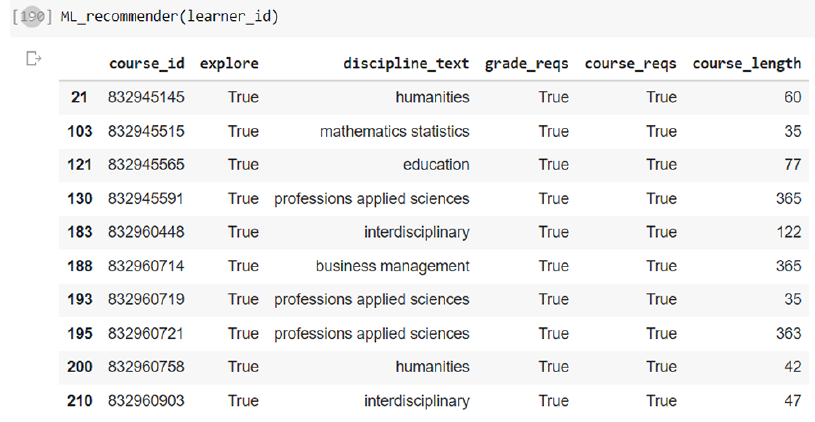
Fig. 9. Machine Learning-based MOOC recommender